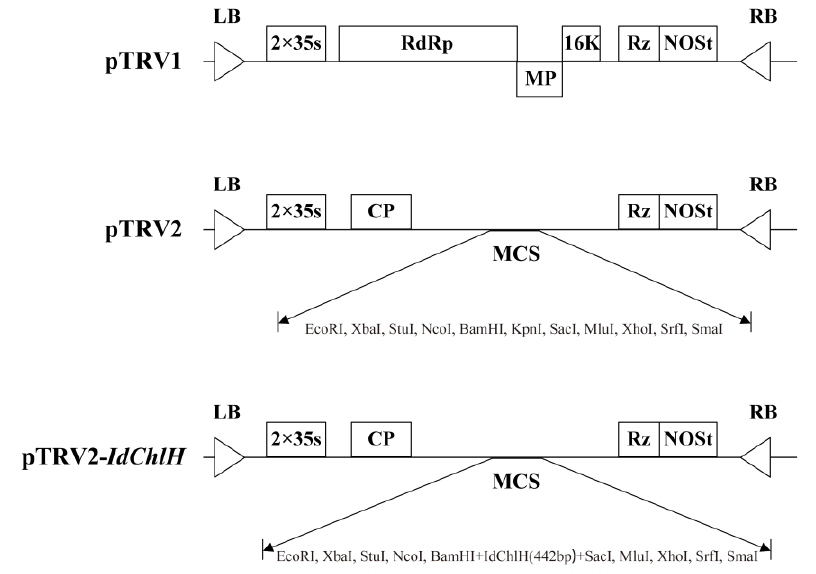
Figure 4. TRV-based VIGS vectors and construction. pTRV2- IdChLH were constructed to analyze the ability of TRV vectors to silence endogenous IdChLH gene in I. dabieshanensis .